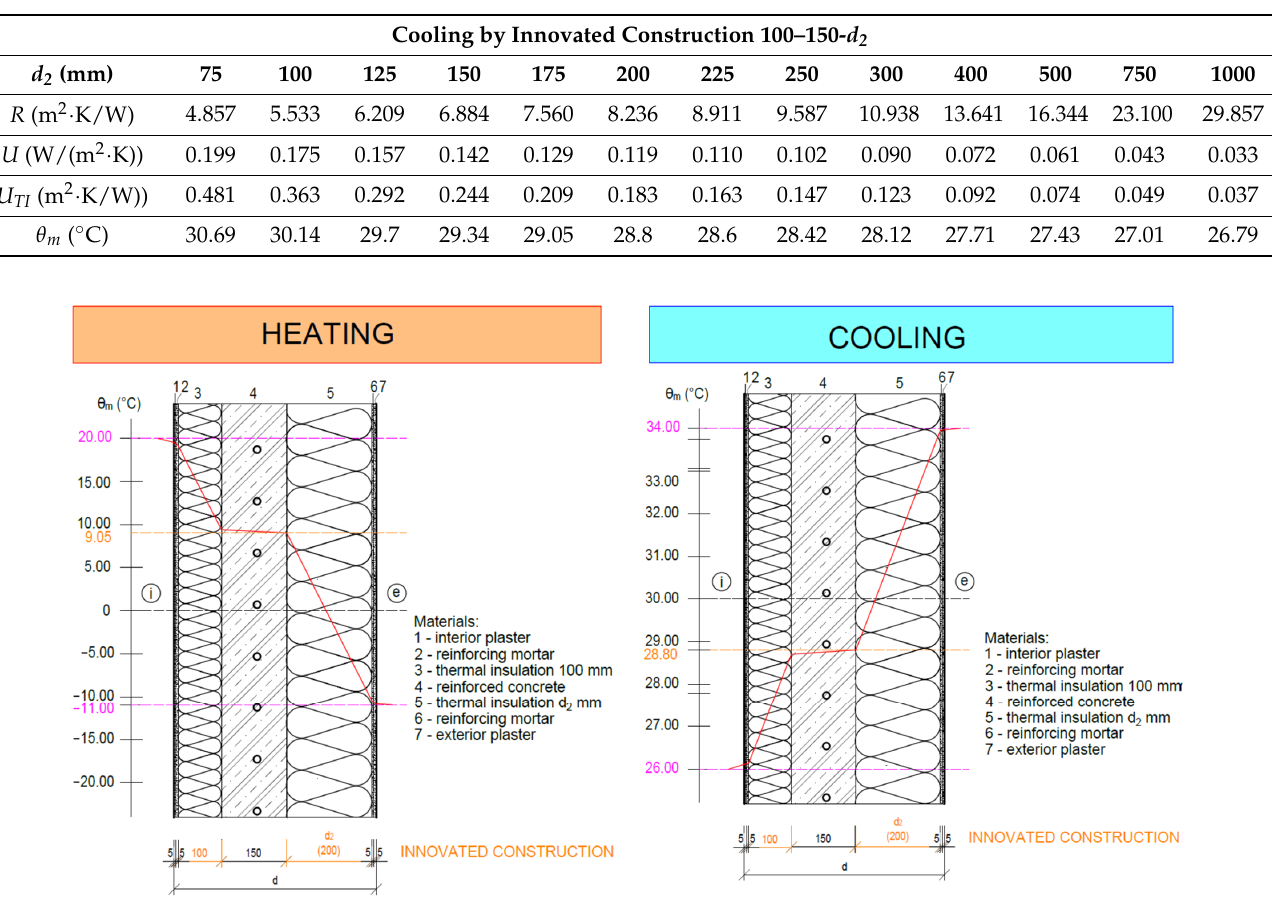
Table 4. Results of calculation of physical variables during the cooling season.